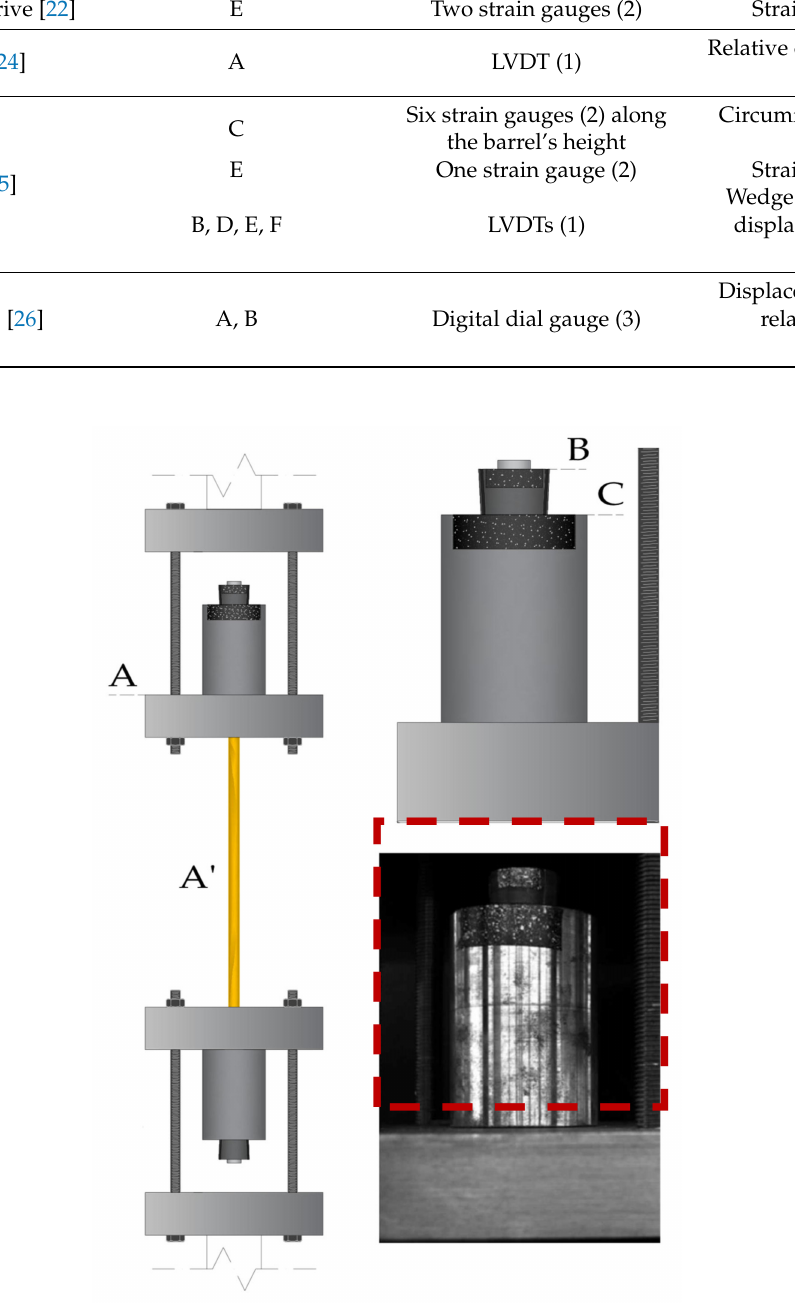
Figure 16. Single and double-angle anchorage—DIC measurement: detail of the monitored